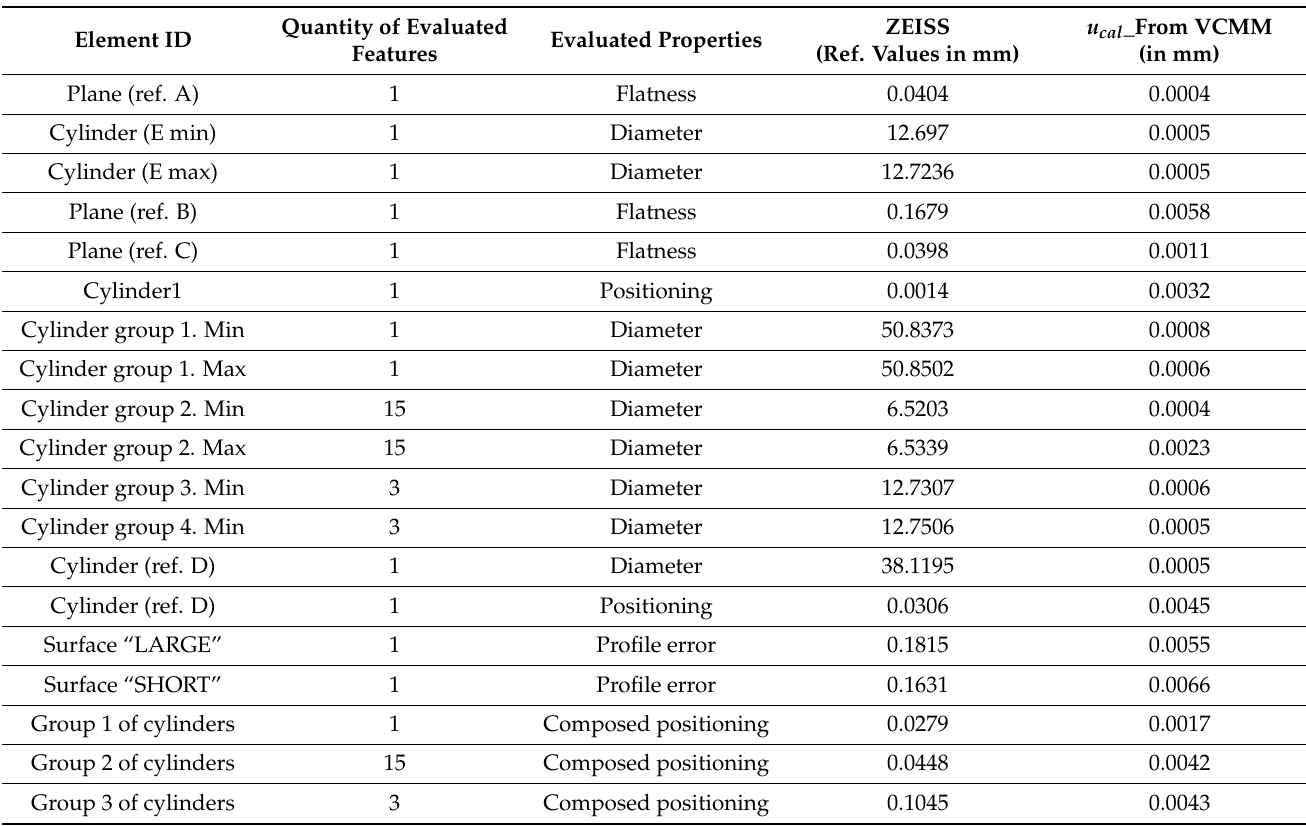
Table 2. ( u cal ) uncertainty contributor according to ISO 15530-4 technical